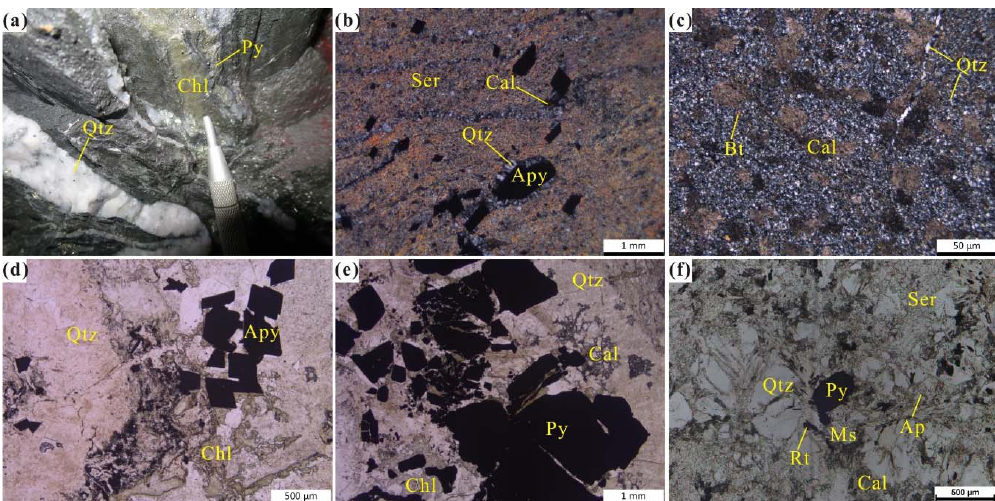
Figure 4. Photographs of various alteration assemblages in the Zhengchong Au deposit. ( a ) Chlorite vein near quartz veins near massive pyrite vein and disseminated pyrite vein. ( b ) Crossed nicols